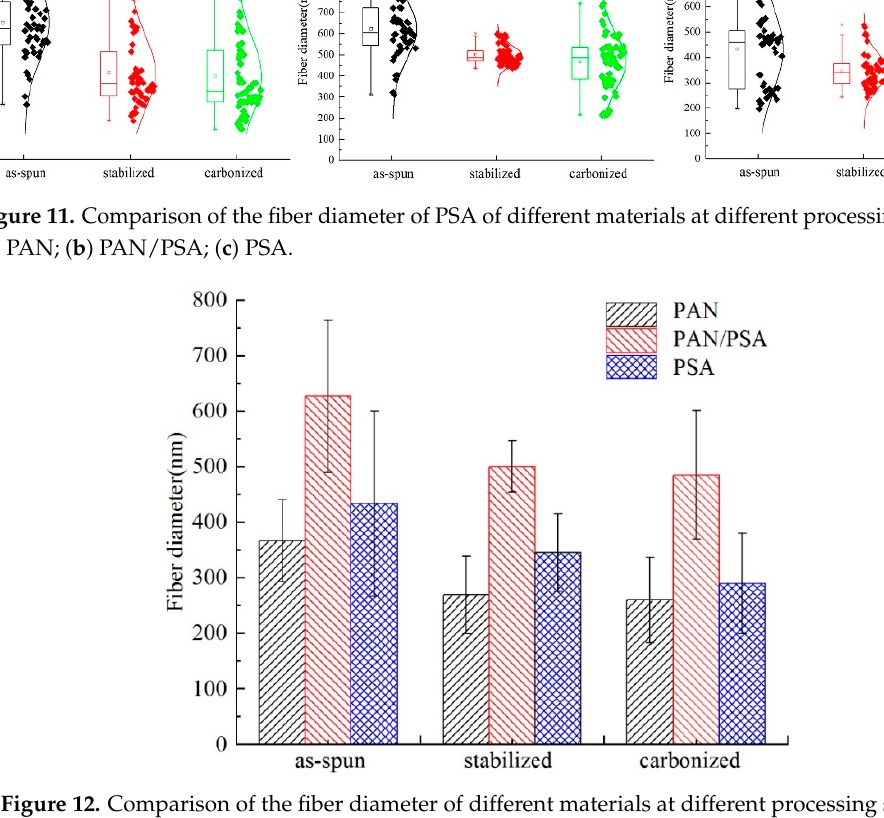
Figure 12. Comparison of the fiber diameter of different materials at different processing stages.